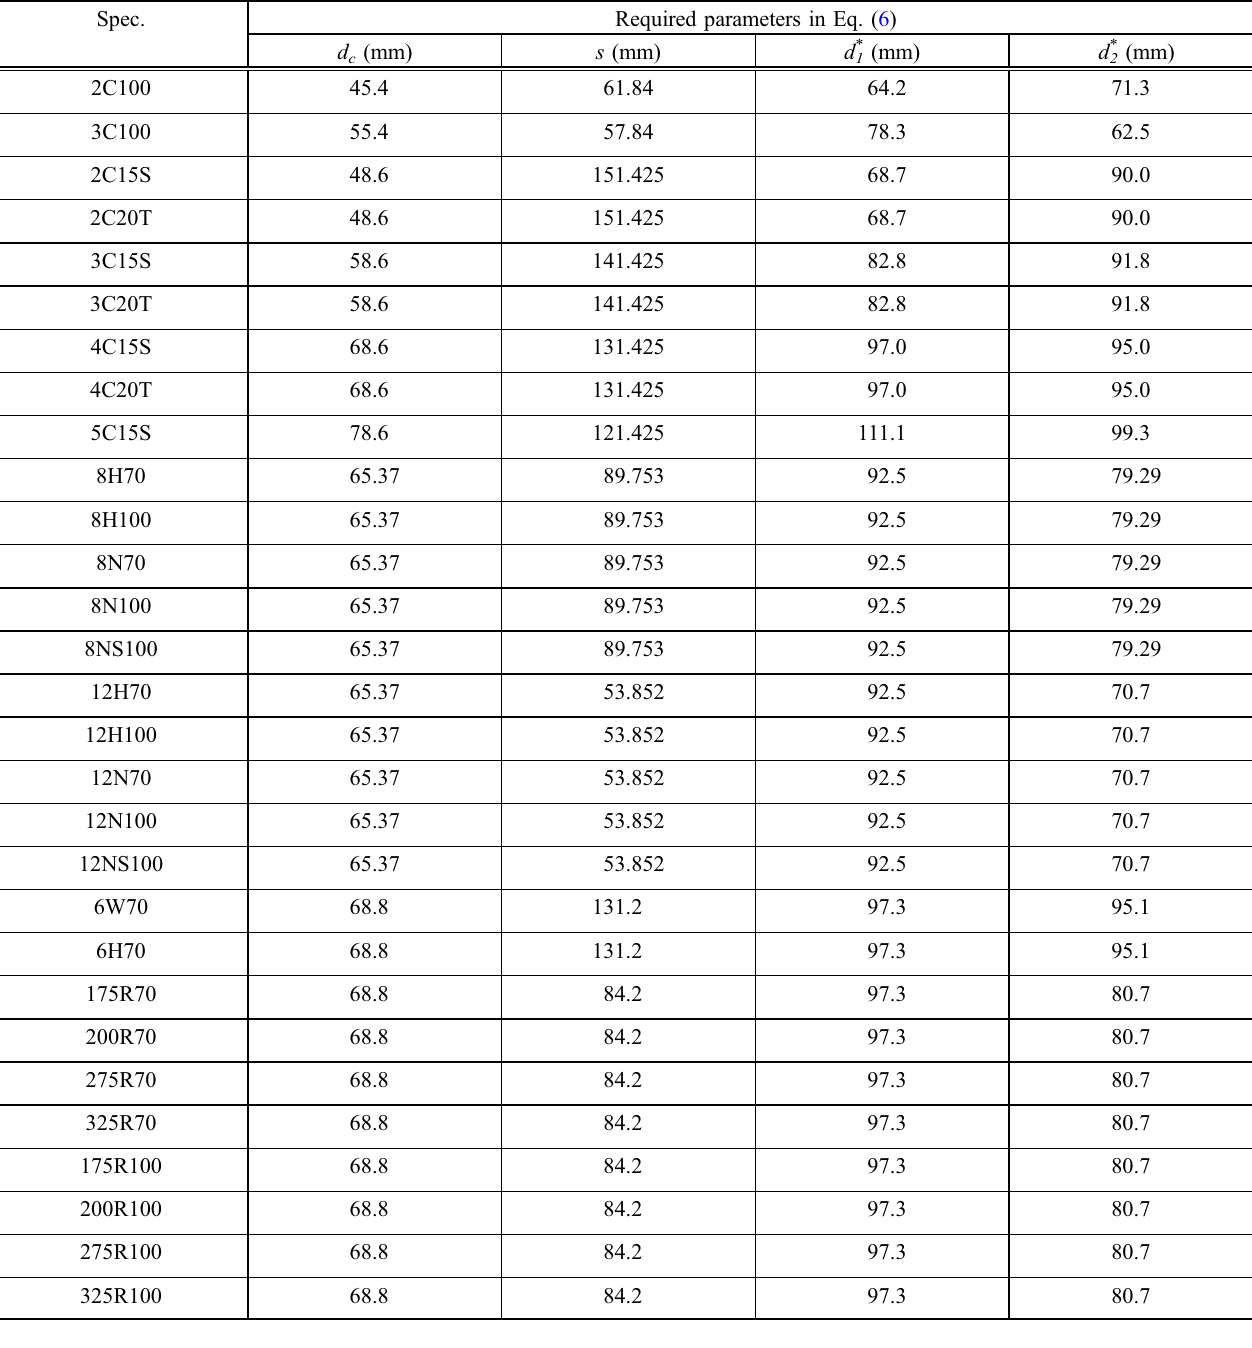
Table 4 Required parameters in Eq. (6).